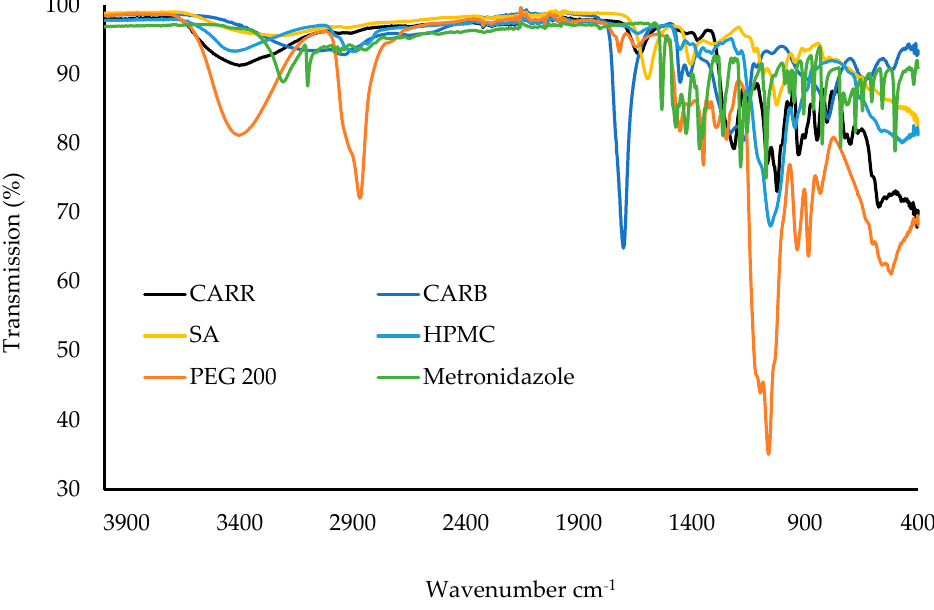
Figure 8. ATR-FTIR spectra of raw materials of CARR, CARB, SA, HPMC, PEG, and MTz.